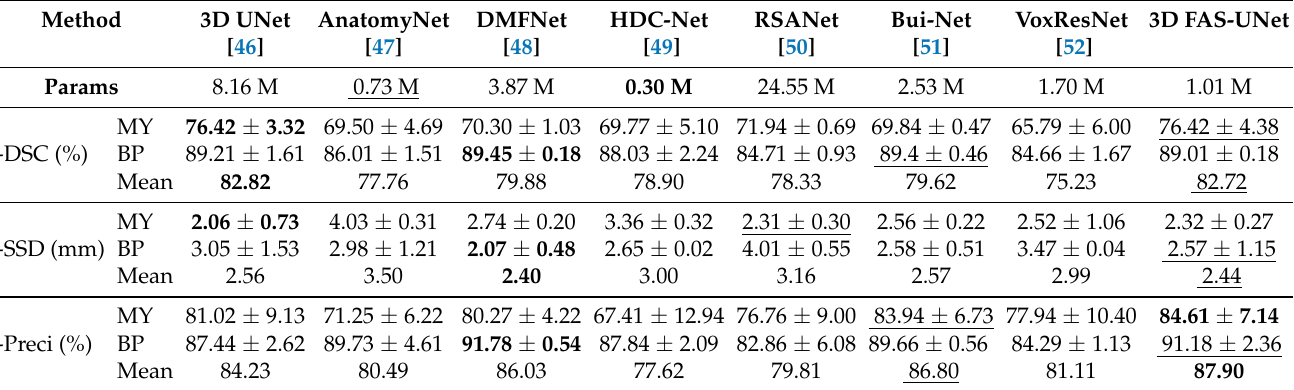
Figure 3. Comparison with the other state-of-the-art networks on the validation set of the 2D SegTHOR datasets. The blue, pink, green, and red regions represent the esophagus, heart, trachea, and aorta, respectively. Form left to right in the first and third rows: the original images, ground-truth, and segmentation results of CANet, CE-Net, and CPFNet, respectively. Form left to right in the second and fourth rows: the segmentation results of ERFNet, LinkNet, 2D UNet, UNet++, and 2D FAS-UNet, respectively. Table 8. Performance comparisons of the proposed 3D FAS-UNet and the popular networks using the a-DSC, a-SSD, and a-Preci values on the 3D HVSMR-2016 validation datasets with both organs: myocardium and blood pool. “MY” and “BP” denote myocardium and blood pool, respectively, “Mean” denotes an average score segmenting all organs. The best and second places are highlighted in bold font and underlined,